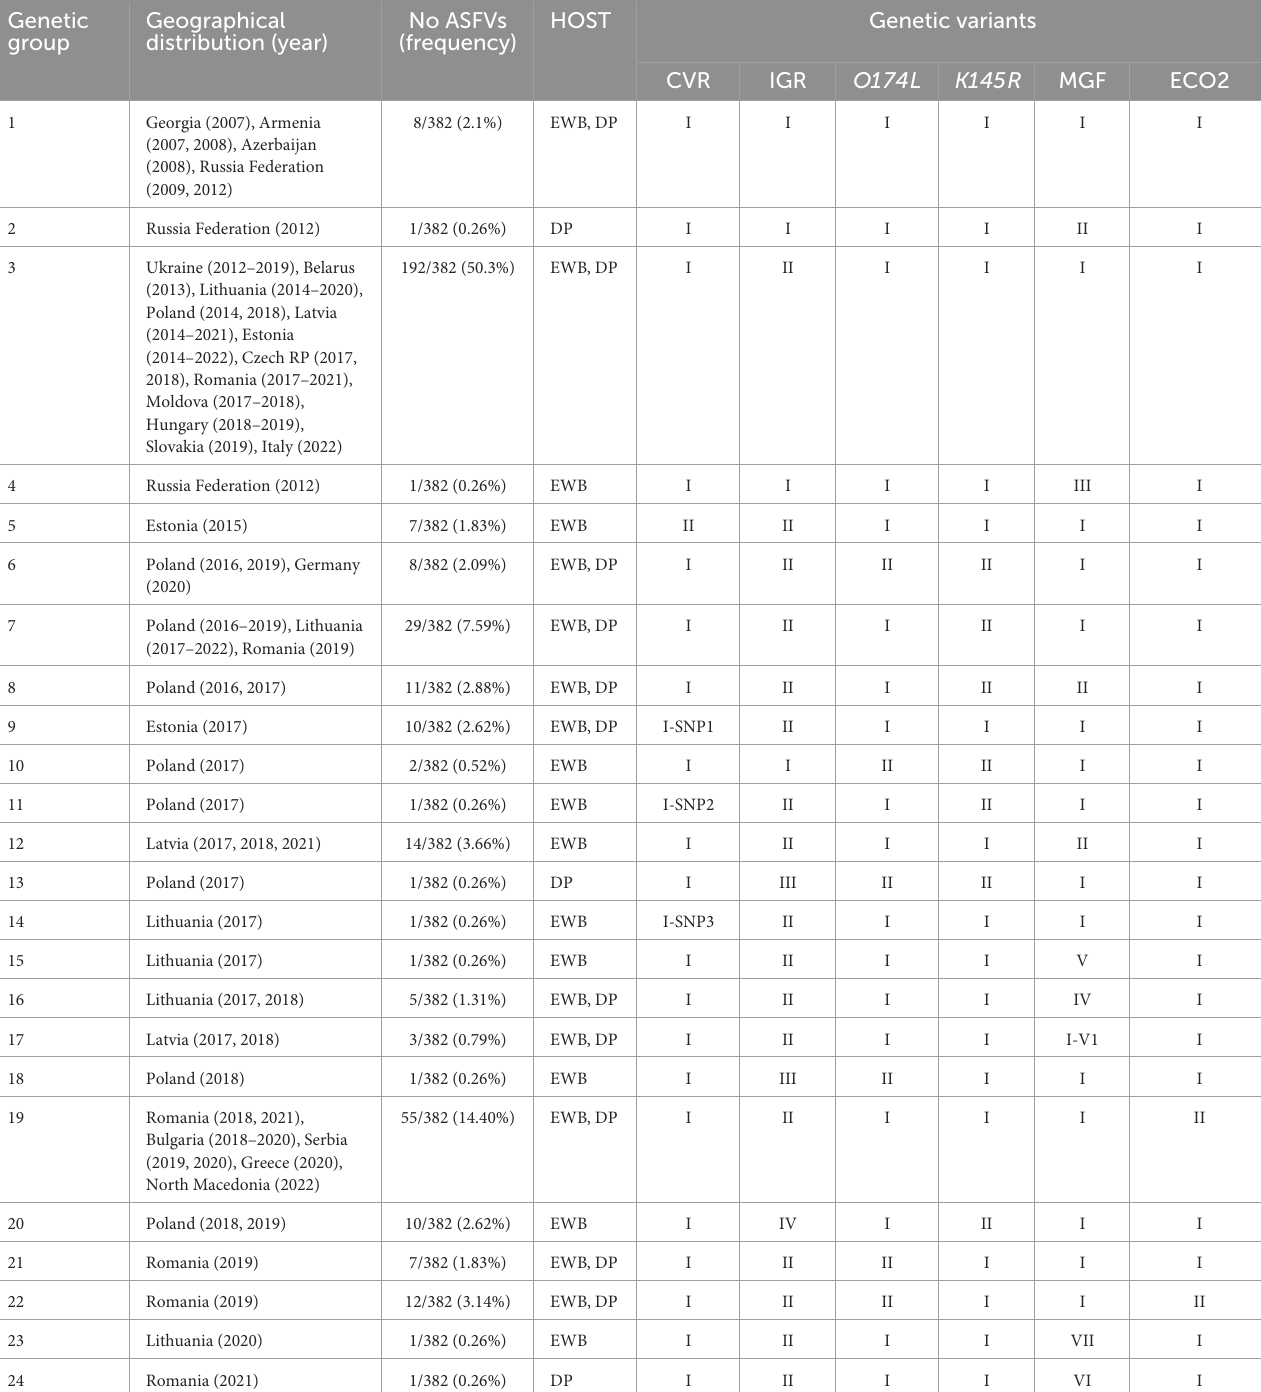
TABLE 4 Groups based on the variants identified in the CVR, IGR I73R / I329L (IGR), O174L , K145R , IGR MGF505 9R / 10R (MGF), and IGR I329L - I215L (ECO2) ASFV variable regions. Genetic